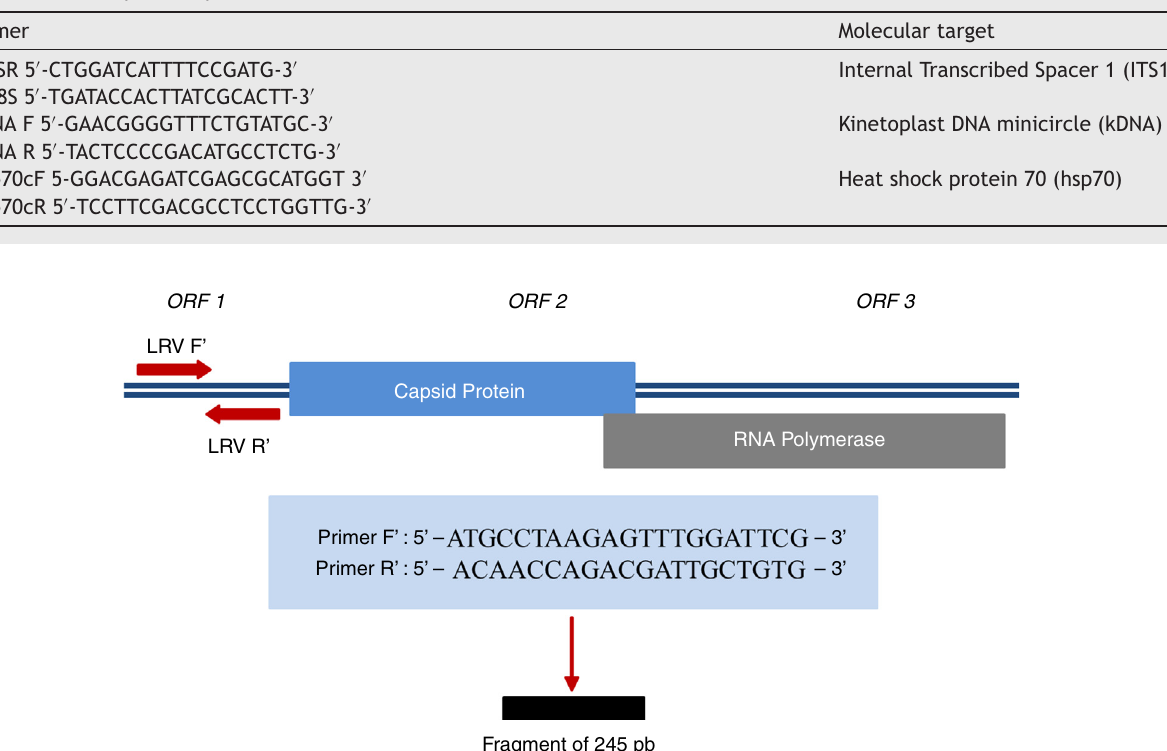
Figure 1 Region amplified for detection of LRV1 and sequences of primers used.